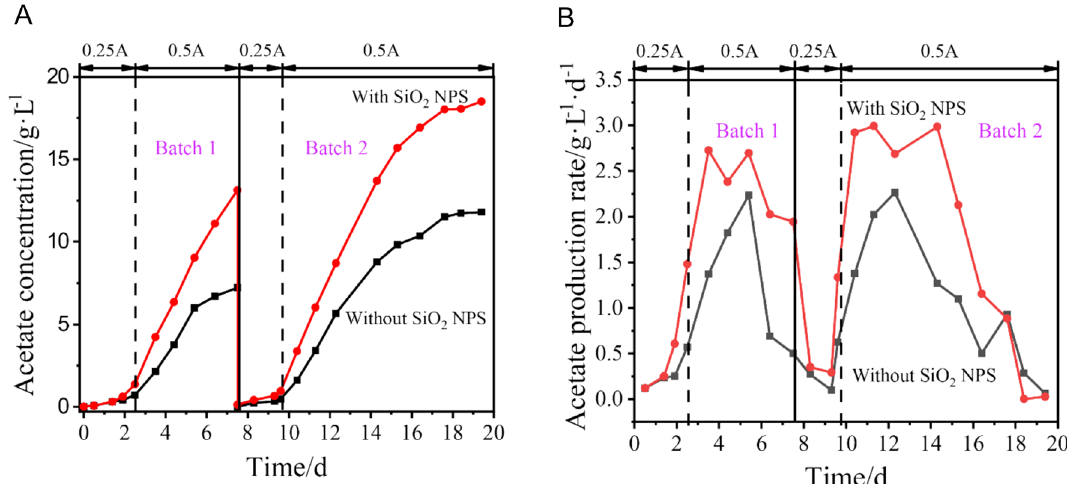
Fig. 4 The acetate concentration ( A) and acetate production rate ( B) of the MES reactor in two